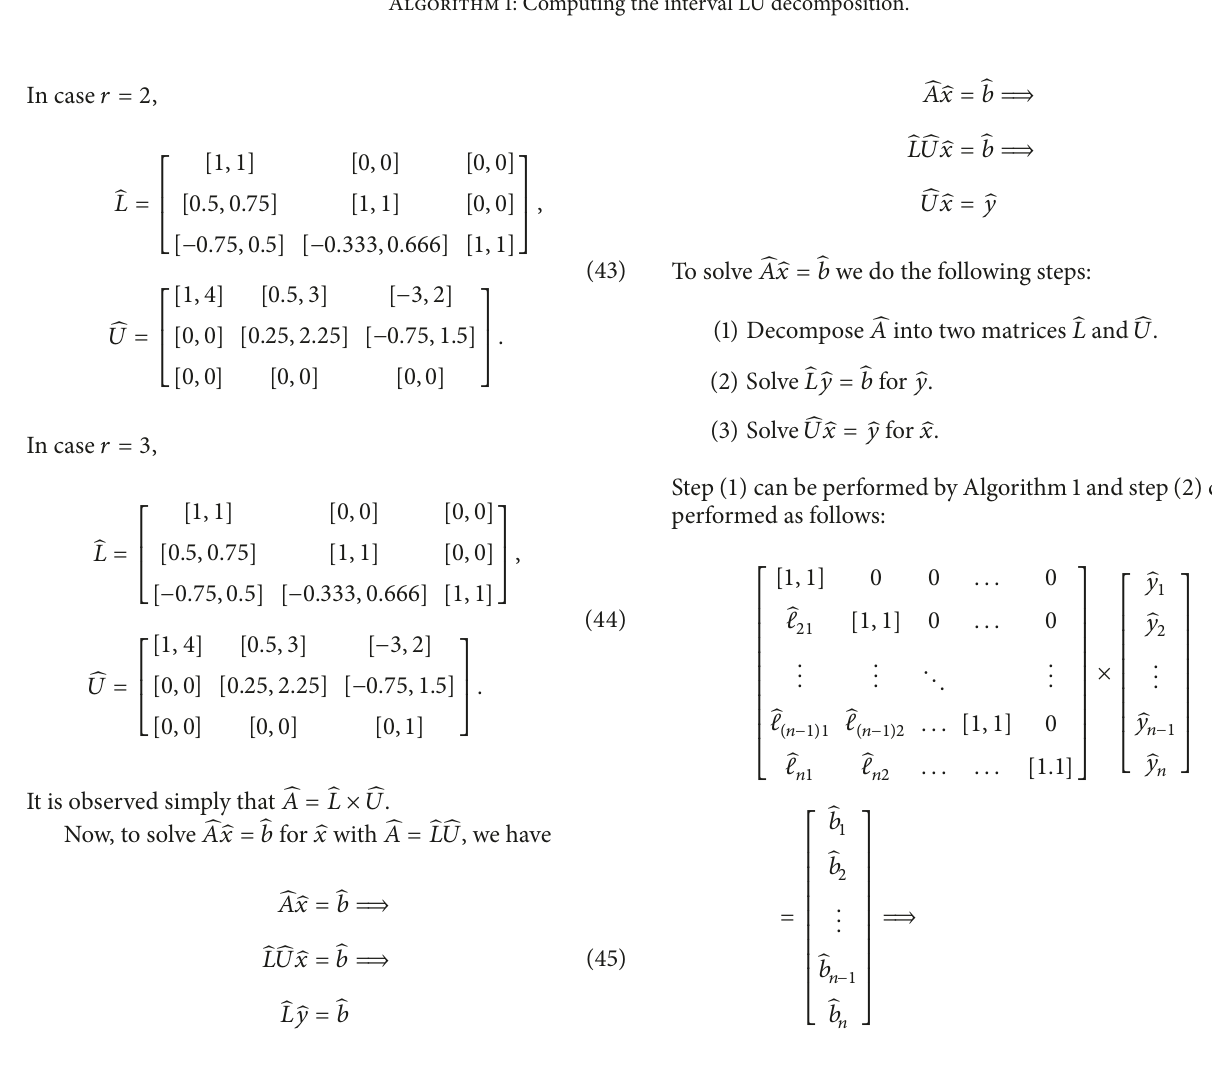
Algorithm 1: Computing the interval LU